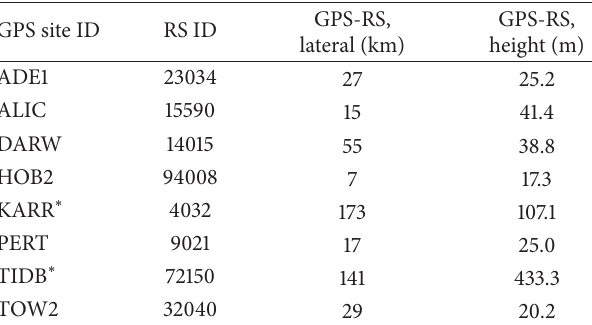
Table 4: Approximate lateral distances (km) and height differences (m) between the GPS and radiosonde (RS)